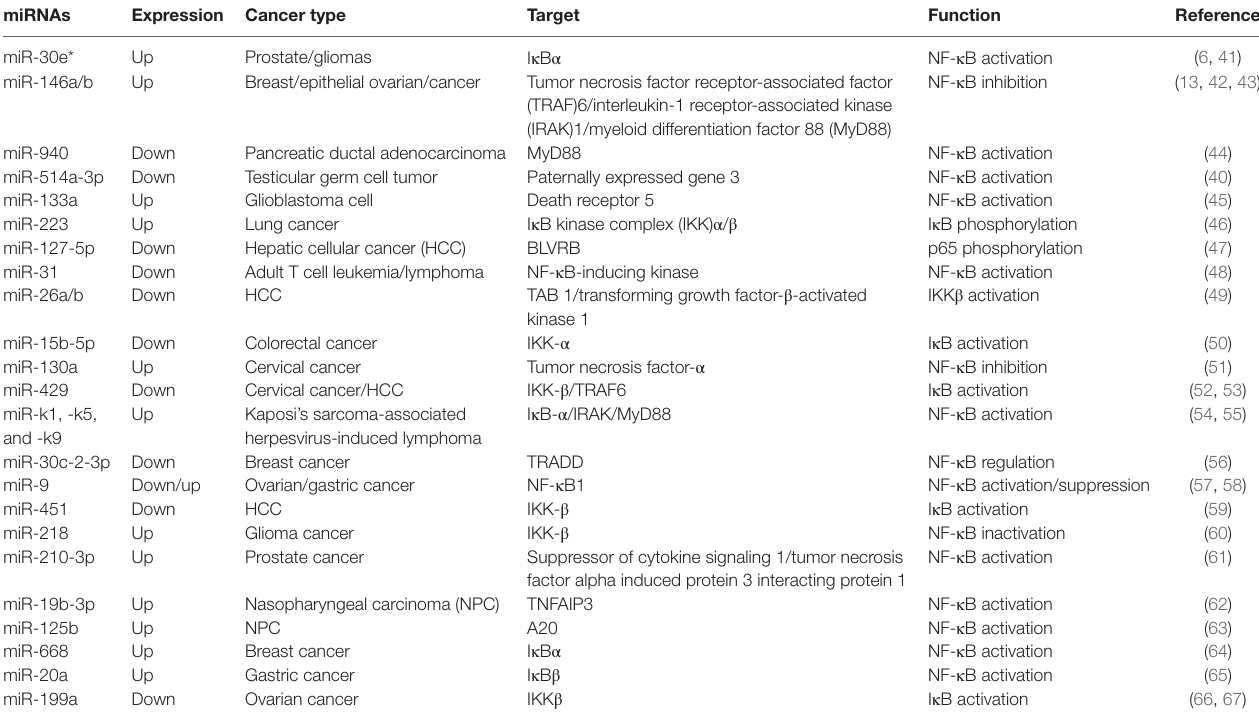
TABLe 1 | MicroRNAs (miRNAs) involved in the regulation of the nuclear factor kappa B (NF- κ B) pathway in cancer.